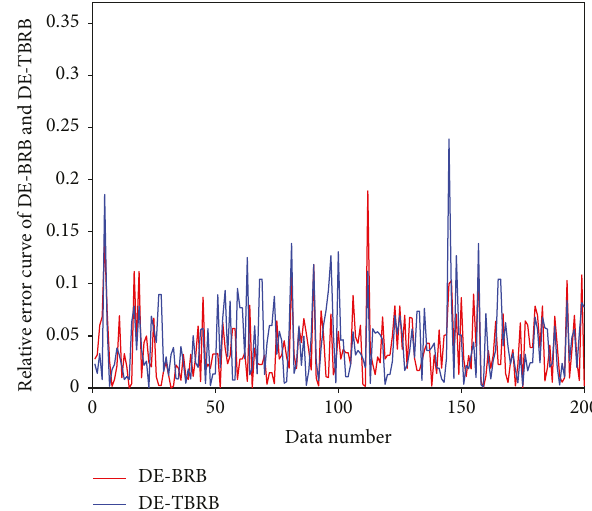
Figure 12: The relative error of DE-BRB and DE-TBRB.